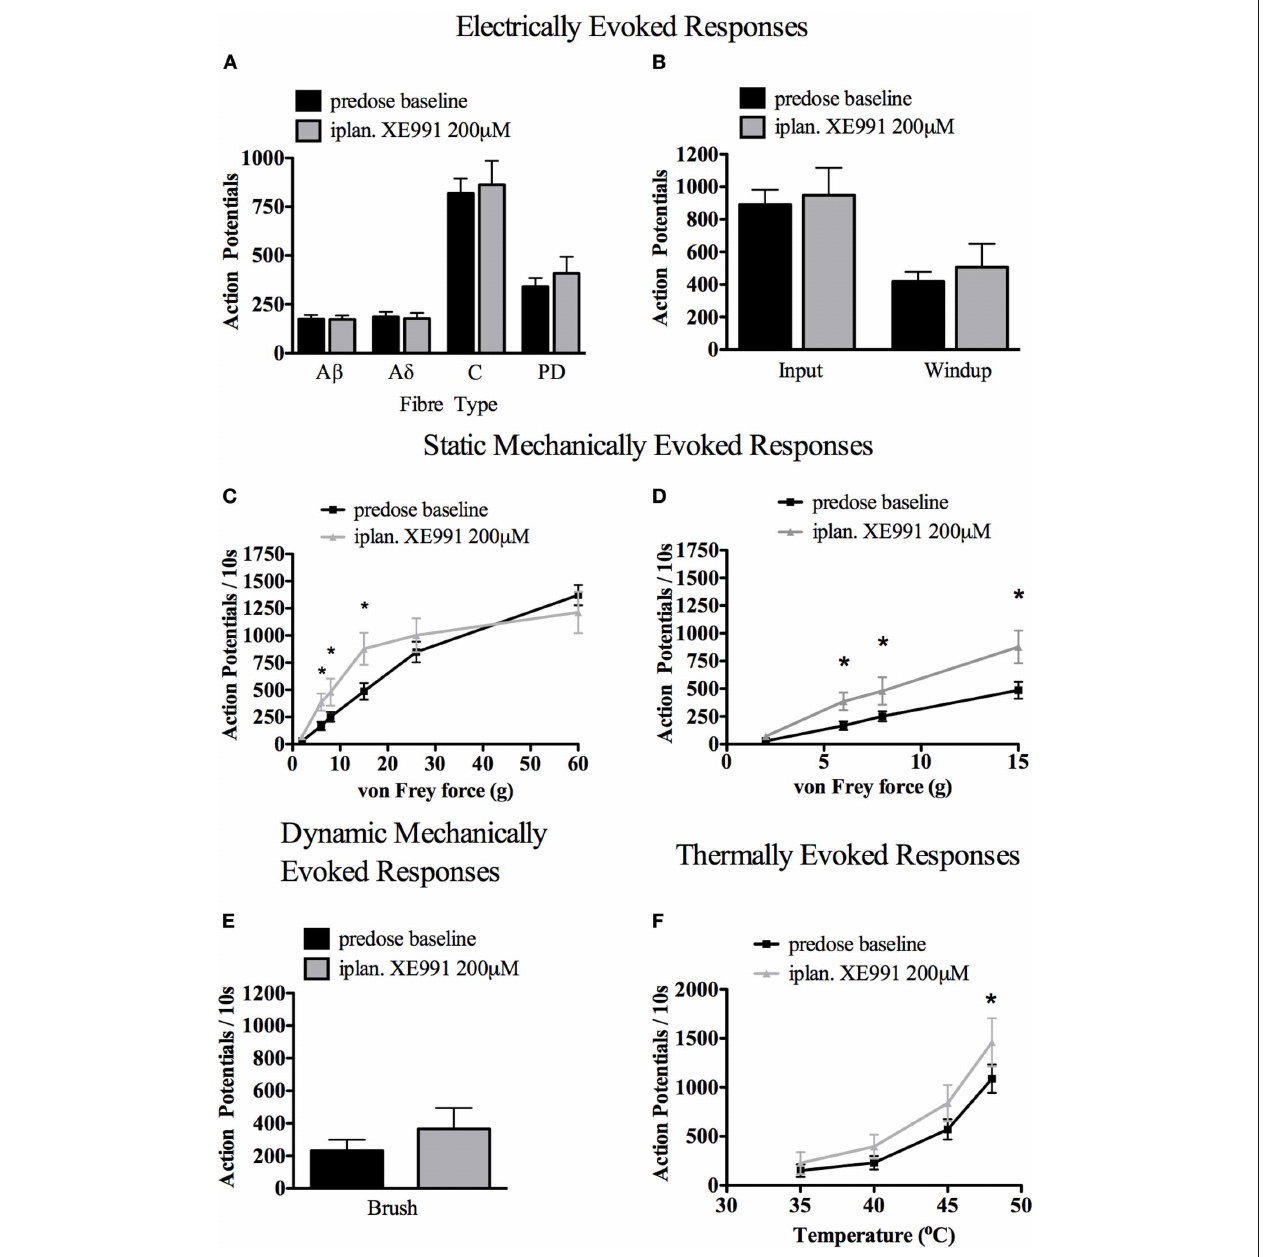
FIGURE 7 | Effect of intraplantar (iplan) XE991 (200 μ M) on evoked electrical, mechanical, and thermal responses in deep dorsal horn wide dynamic range (WDR) neurons. While XE991 had no significant effect on electrically-evoked responses ( A and B ) nor brush-evoked responses (E), low-medium range mechanical (C) with expanded view of low range von Frey